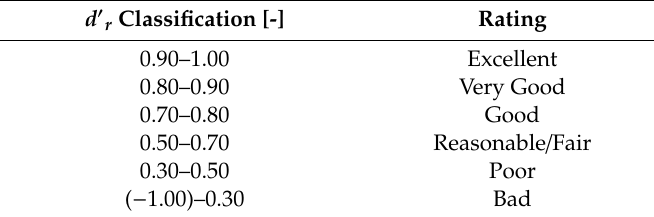
Table 2. Proposed classification of the relative refined index of agreement d (cid:48) r and corresponding